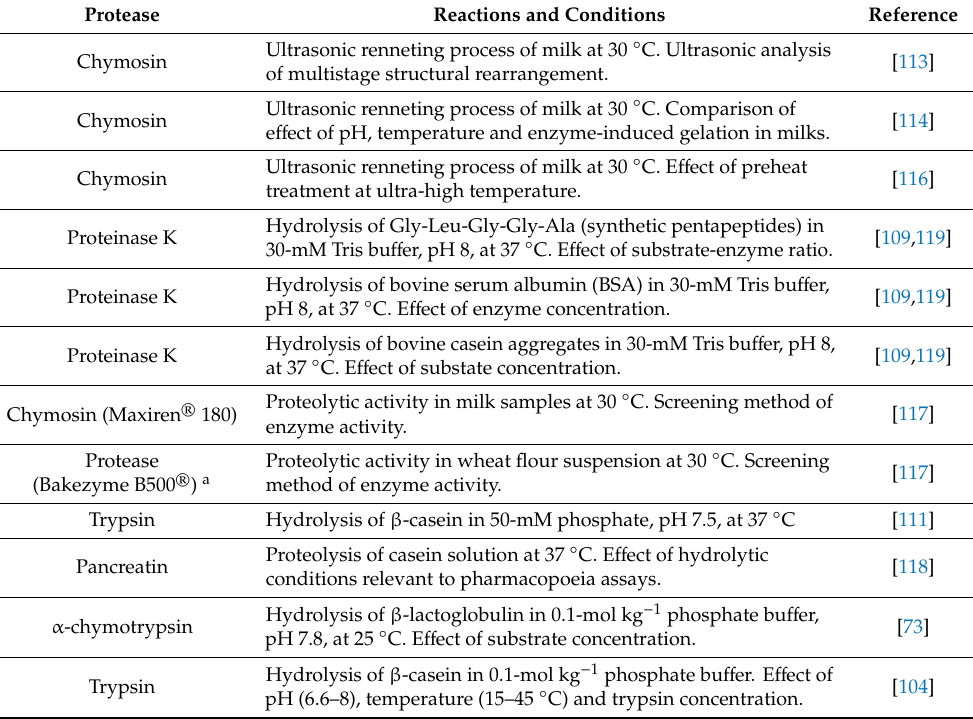
Table 1. Ultrasonic monitoring of thee proteolytic of the milk protease and milk proteins described in the literature. Protease Reactions and Conditions